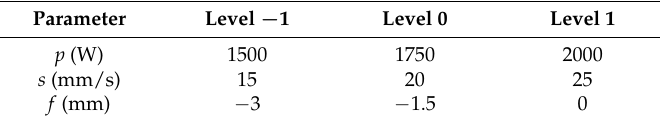
Table 3. Factor levels for the input parameters.